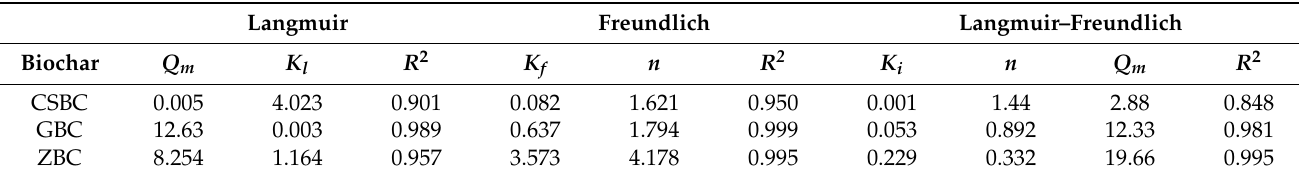
Table 3. Parameters for the adsorption isotherm for P removal by GBC, CSBC, and ZBC. Langmuir Freundlich Langmuir–Freundlich